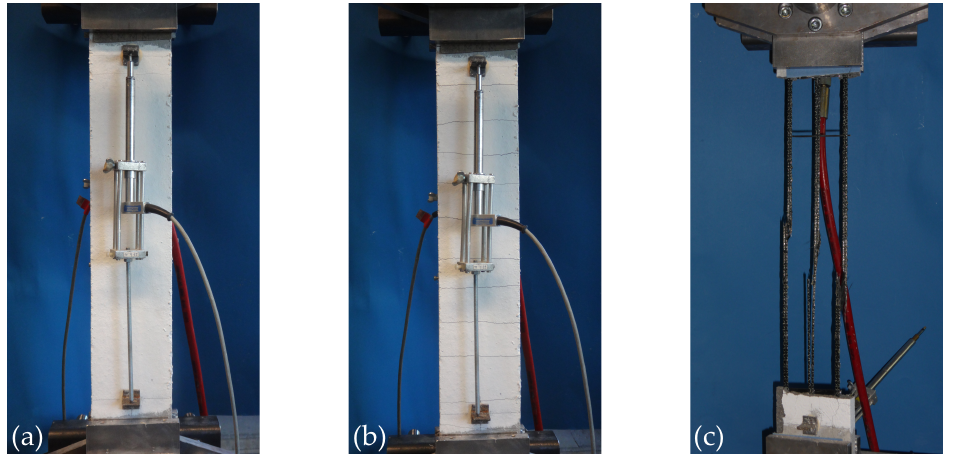
Figure 8. Stages of a tensile test: installed test specimen with slight cracking ( a ), specimen featuring complete crack formation ( b ) and specimen after failure ( c ), photographs by IMB, RWTH Aachen